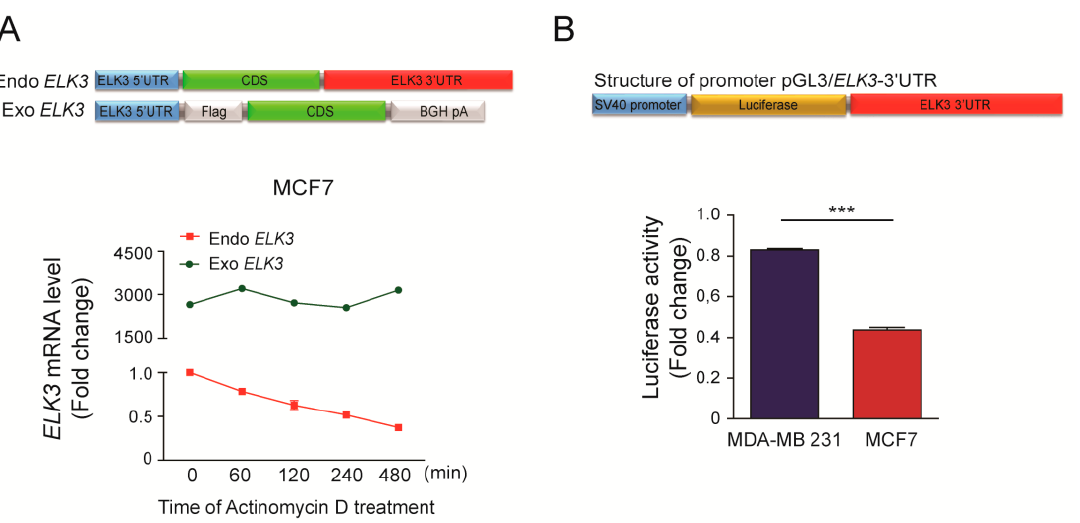
Figure 2. 3’UTR determines the stability of the ELK3 mRNA. ( A ) Stabilities of the endogenous ELK3 mRNA and an exogenous form lacking the 3’UTR in MCF7 cells. The cells were transfected with the exo-form of ELK3 and treated with actinomycin D (2.5 µ g / ml) for the indicated times. The levels of the exo- and endo-forms of the ELK3 mRNA were analyzed by qRT-PCR. The endo-form was detected with primers targeting the 3’UTR, and the exo-form was detected with primers targeting the region spanning the Flag tag to the coding sequence of ELK3 . ( B ) The luciferase activity in MDA-MB 231 and MCF7 cells transfected with a luciferase reporter plasmid harboring the 3’UTR of ELK3 . Error bars represent the S.E.M.; *** p < 0.001 (Student’s t -test).